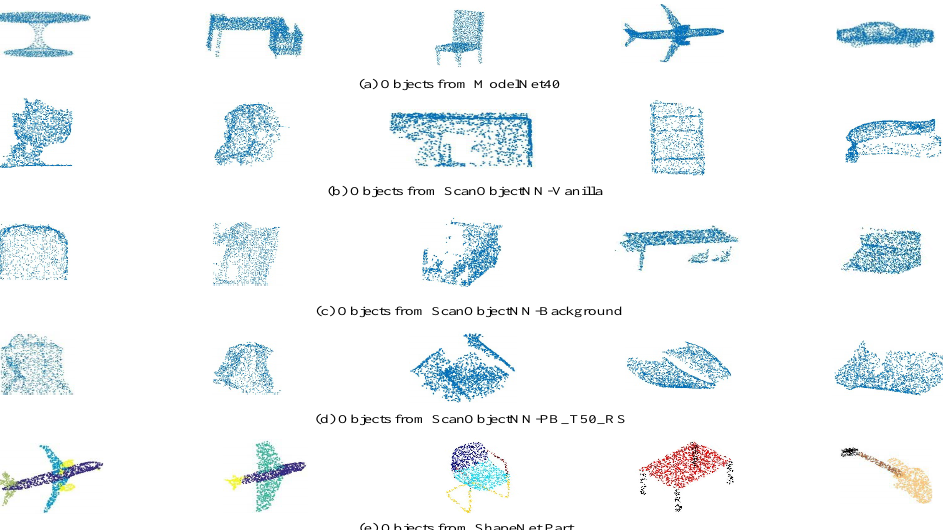
Figure 4. Shapes from ModelNet40, ScanObjectNN, and ShapeNet Part datasets. The categories are highly imbalanced for ModelNet40 and ShapeNet Part datasets, which are shown in the subfigures ( a ) and ( e ) respectively. The shapes in ScanObjectNN datasets are noisy and have geometric distortions, and we show shapes from the three variants of the ScanObjectNN dataset in ( b – d ). In this figure, for every dataset, the first two shapes are of the same category, and they have divergent appearances or point